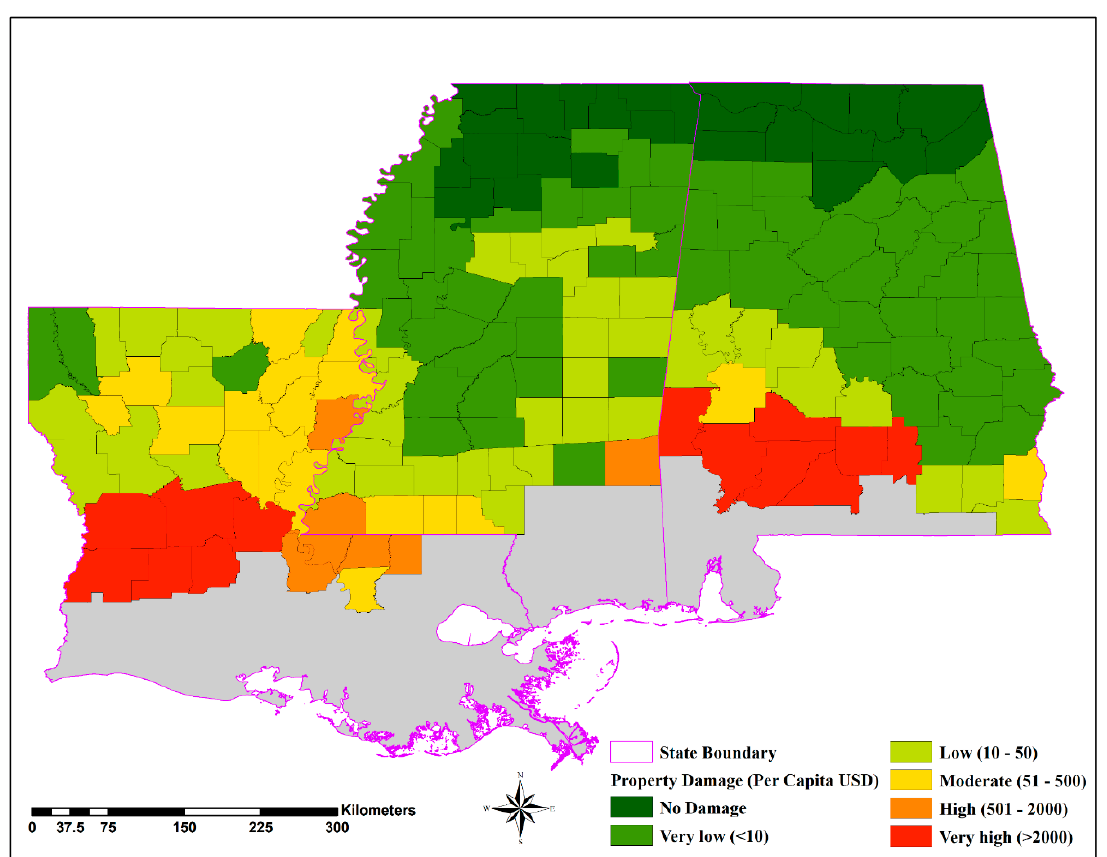
Figure 2. Per capita property damage spatial distribution in the inland counties. Regionally, the southern part of the study area sustained higher per capita damage compared to the northern part. In particular, the southwestern Alabama and Louisiana region had the highest per capita damage (>USD 2000) and counties in inland Mississippi had the lowest average per capita damages (Figure 2). Inland counties in Alabama had the highest average property damages (USD 2134.85 average per capita damage) followed by inland counties in Louisiana (USD 1617.12 average per capita damage). In fact, 7 out of the 10 highest per capita damages sustained by the counties during the study period are in Alabama and 3 of them are in Louisiana. Inland counties in Mississippi had mostly very low-moderate level of per capita damages (>USD 50) with a few exceptions (some southern counties in this state had moderate–high per capita damages). A total of 25 counties in the study area had no damages reported during 1996–2018, located in northern Alabama and Mississippi.